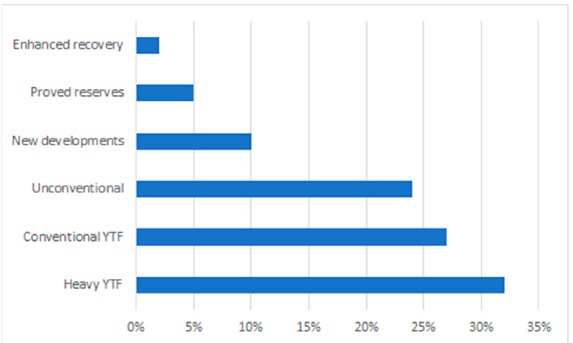
Figure 1. Total energy supply in ktoe in the world from 1990 to 2018. Extracted from IEA [1].